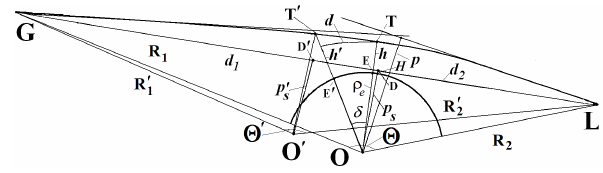
Figure 1. Scheme of radio occultation